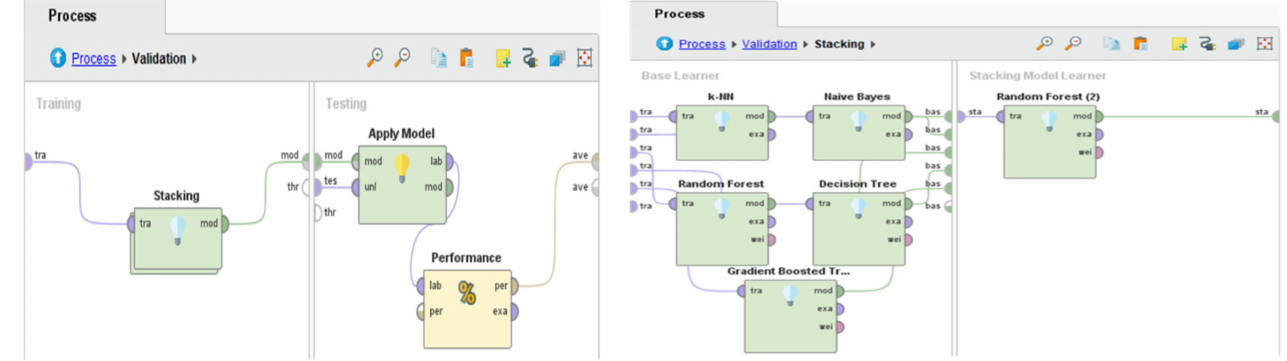
Figure 6. Model implementation using stacking (step 1 and